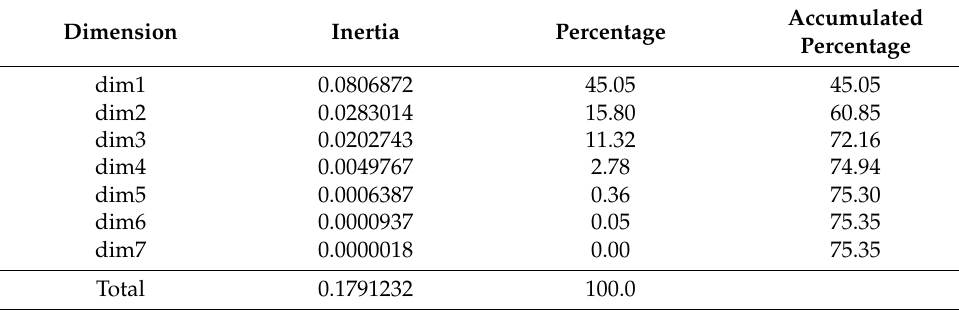
Table 4. Degree of explanation of total inertia.